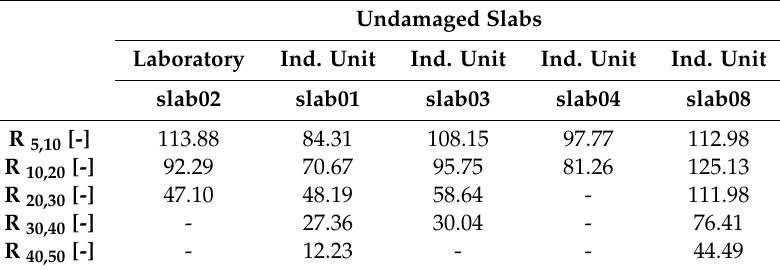
Table 10. Summarization of residual strength factors data.